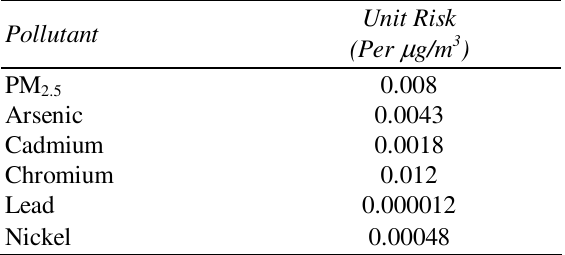
, As, Cd, Cr, Pb, and Ni 2.5